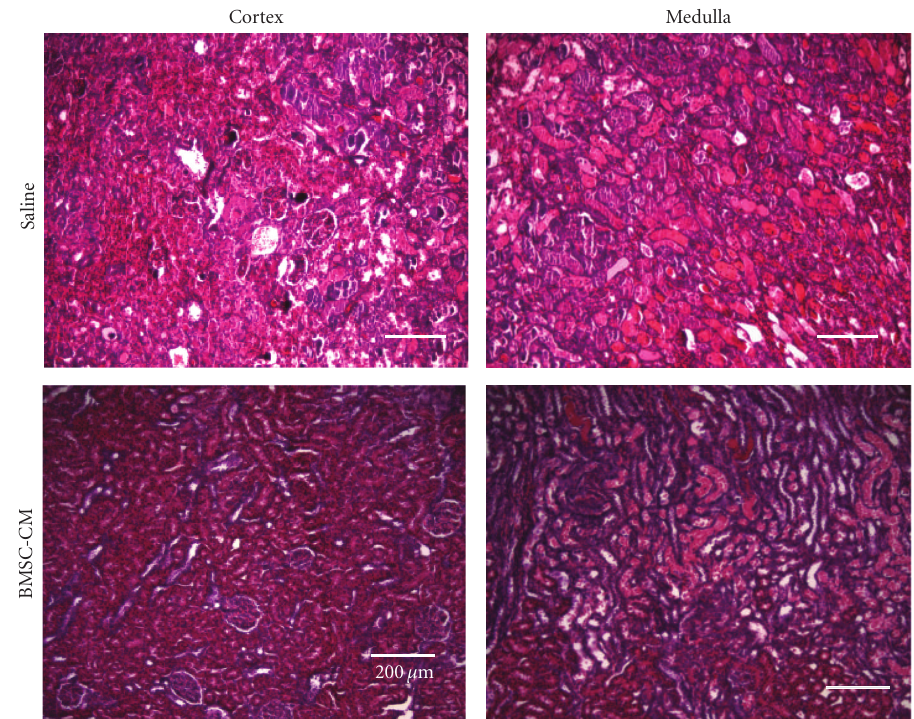
Figure 3: BMSC-CM protects the native architecture of the kidney during AKI . Hematoxylin and eosin staining of sections of kidneys from rats administered a lethal dose of cisplatin (7.5mg/kg) and sacrificed at 5 days following cisplatin administration. The rats were treated at 3, 9, 24, 48, and 72 hours following cisplatin administration, with 1 mL of either physiological saline ( n = 4), or BMSC-conditioned medium ( n = 3) i.v. Scale bar = 200 μ